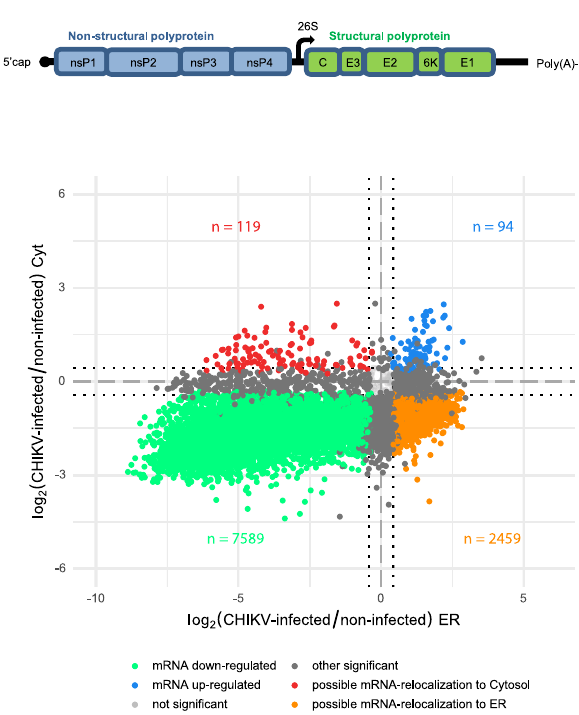
Fig. 1 CHIKV infection alters the cell host transcriptome. a Scheme of CHIKV RNA genome. b Transcriptome analyses of the cytosol (Cyt) and ER compartments in CHIKV-infected cells. Genes were plotted according to their log 2 fold changes in CHIKV infected vs . non-infected cells for both translation compartments. The sequencing reads were analyzed using a custom transcriptome annotation and differential expression was determined via limma-voom (see Methods). Colors indicate genes that are signi fi cantly (FDR < 0.05) down-regulated in both compartments (green), up-regulated in both compartments (blue), up-or down-regulated in only one compartment (dark grey) or show opposing behavior in the two compartments (orange and red). Dotted lines indicate log 2 fold changes of ±0.433 (i.e. a 35% change in either direction) used as minimum threshold to declare mRNA levels as changed. HEK 293T cells were infected at a MOI of 4 and samples collected at twelve hours post-infection. Three independent replicates were carried for each